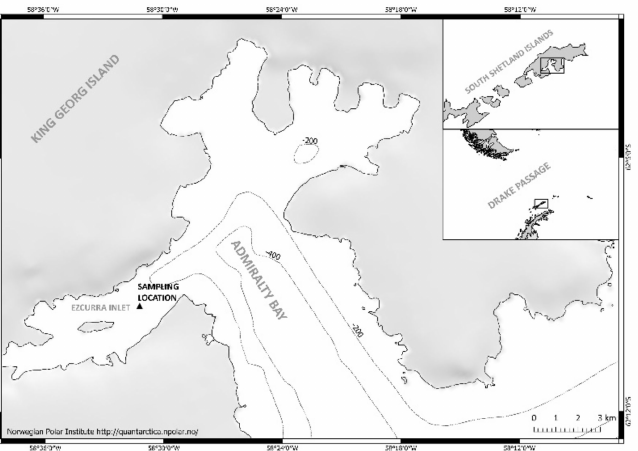
Figure 1. Geographic position of the sampling station in Admiralty Bay, Ezcurra Inlet (King George Island), December 2003–November